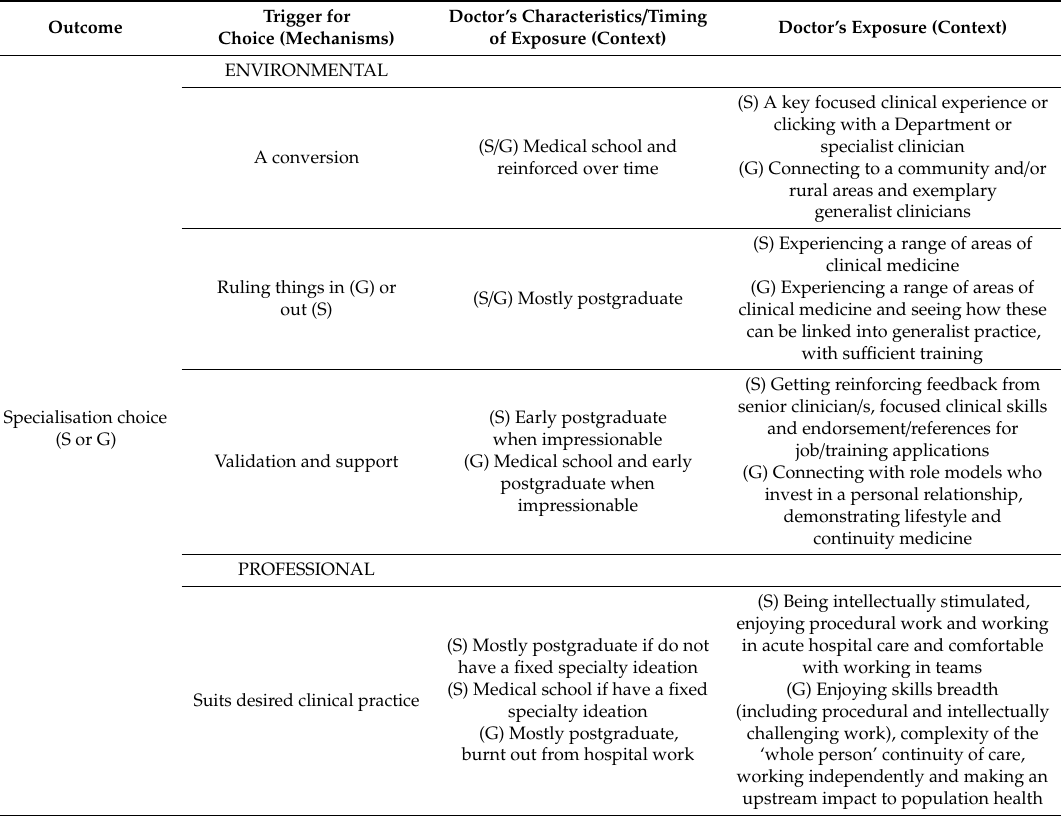
Figure 1. Mechanisms to produce a generalist or specialist doctor. For the mechanism ruling in or out. Table 4. Full theory about exposures (C) for doctors at di ff erent stages of training (C) triggering choice (M) to be a generalist or specialist doctor (O) a